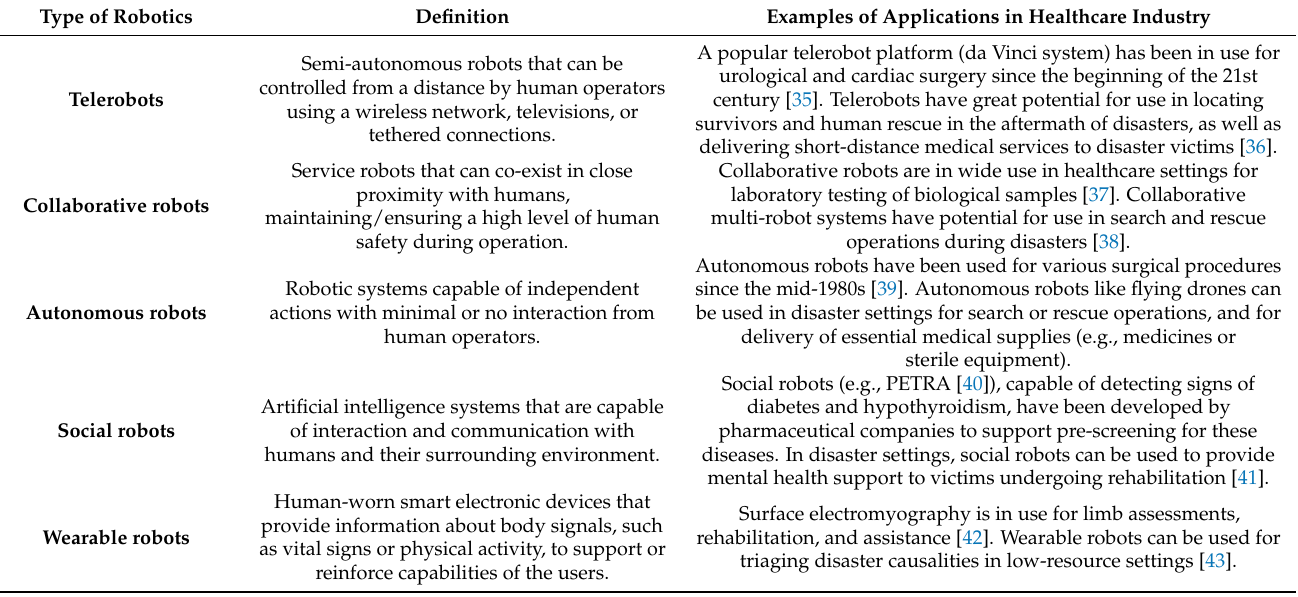
Table 1. Robots and their application in delivery of